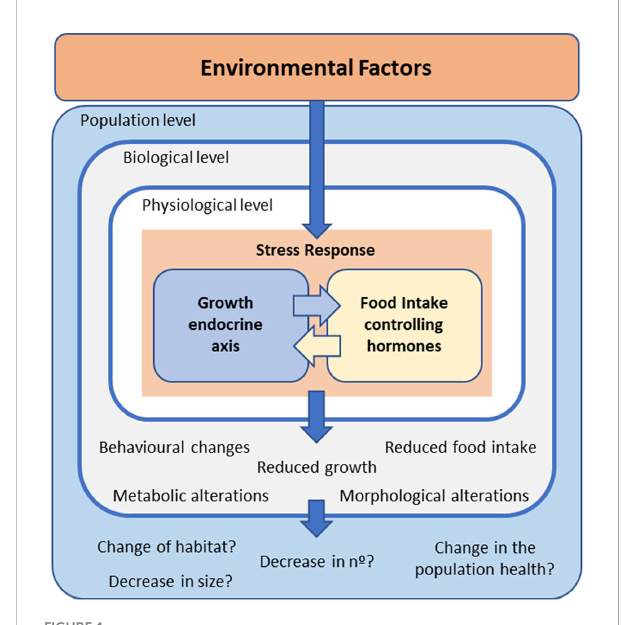
FIGURE 1 Schematic representation of how environmental factors activate a stress response in fi sh, which includes modi fi cations in the interrelated growth – and food intake – endocrine axes. The possible consequences at different levels of biological organization are also